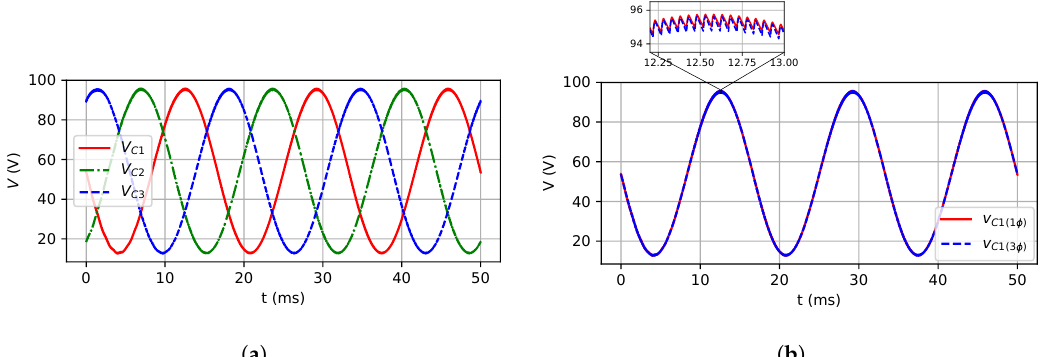
Figure 12. Capacitor voltages for R load case: ( a ) Three-phase model; ( b ) Single-phase and three-phase (leg 1) models.